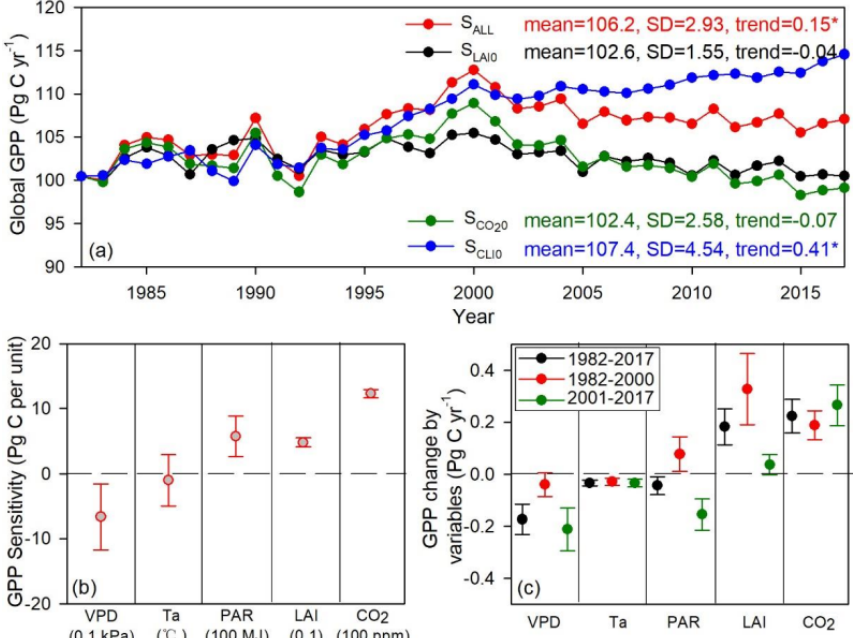
Figure 8. Long-term changes in global GPP and the environmental regulations: (a) global summed GPP derived from the four experimental simulations in Sect. 2.5; (b) GPP sensitivity to climate variables (i.e., VPD, Ta, and PAR), LAI, and atmospheric CO 2 ; (c) contributions of climate variables (i.e., VPD, Ta, and PAR), LAI, and atmospheric CO 2 to GPP changes over 1982–2017, 1982–2000, and 2001–2017. The asterisk indicates the significant level at p value <